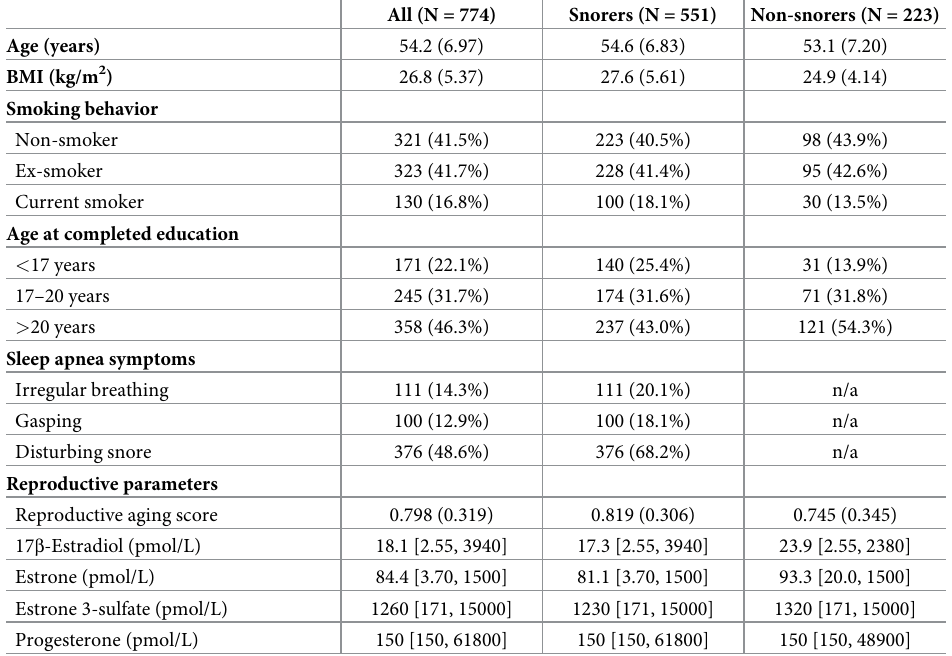
Table 2. Characteristics of the study population and by reported